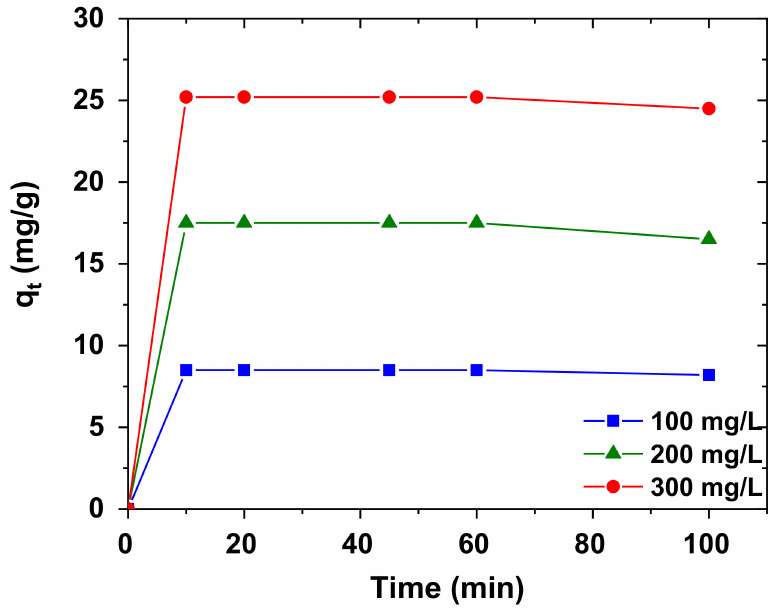
Figure 12. Adsorption kinetics of AB92 onto Nd 2 O 3